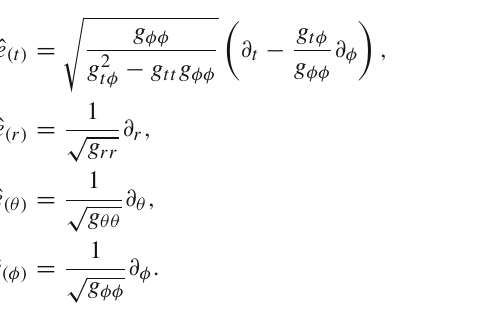
According to the schematic diagram Fig. 2, the